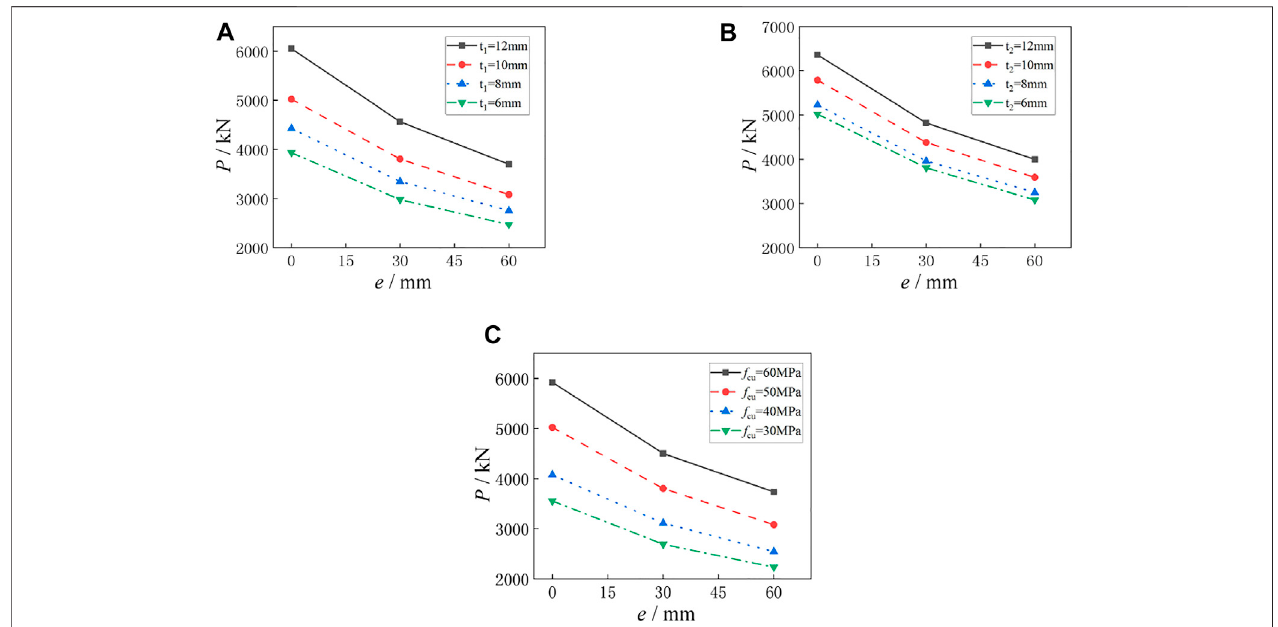
FIGURE 12 | Comparisons of ultimate bearing capacity of specimens with different eccentricities. (A) Specimens with different GFRP thicknesses. (B) Specimens with different steel tube thicknesses. (C) Specimens with different concrete strengths.